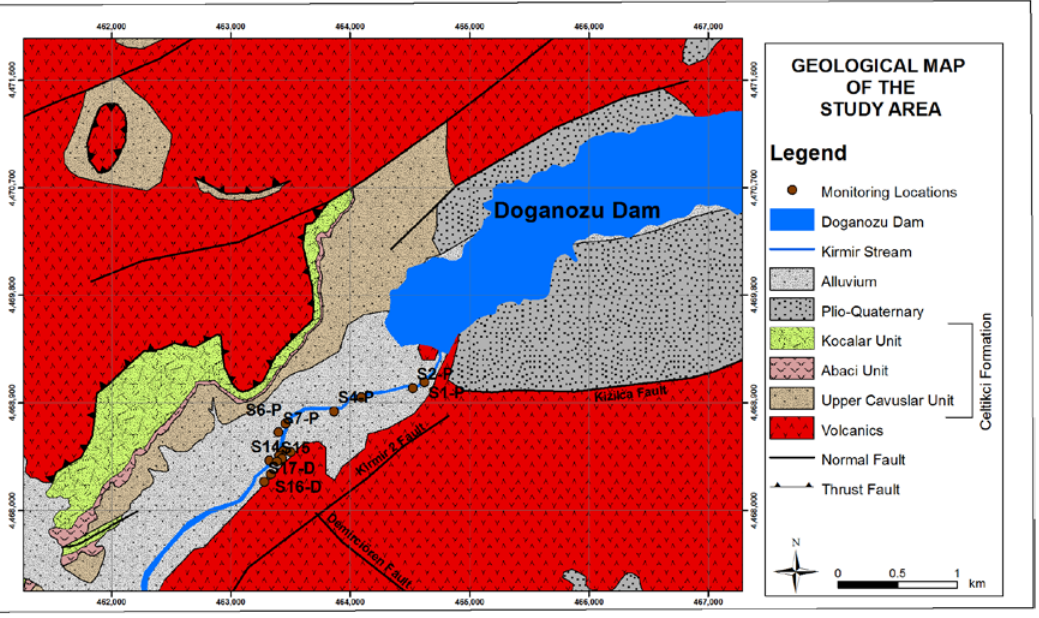
Figure 3. Geological map of the study area [31].